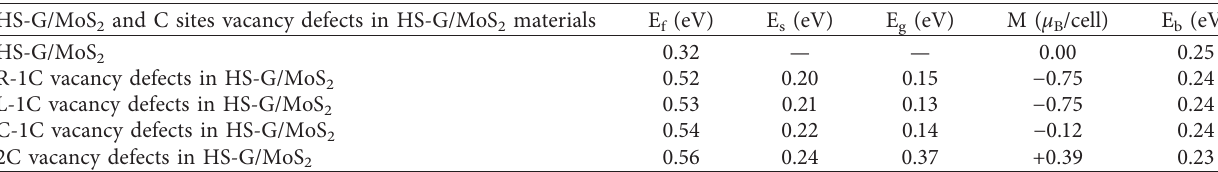
Table 1: Fermi energy level (E f ), Fermi energy level shift towards conduction band (E s ), the energy gap between the bottom of the conduction band and top of the valence band (E g ), the total value of magnetism (M), and binding energy (E b ) of HS-G/MoS 2 and C sites vacancy defects in HS-G/MoS 2 materials.